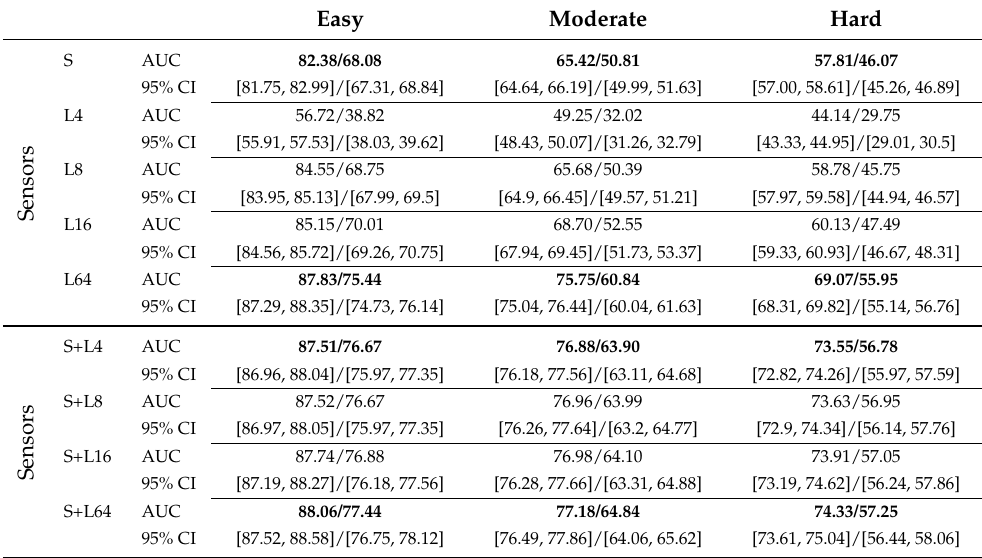
Table 5. Evaluation of 3D object detection performance by a stereo camera, different types of LiDARs, and the fusion of those. In the upper part of the table, the performance (measured using the area under the curve (AUC) in the P–R curve) and the confidence interval(s) (CI) of the stereo camera and LiDAR 4, 8, 16, and 64 beams are shown with respect to three levels of difficulties for objects to detect (easy, moderate, and hard). The bottom of the table presents the detection performance and CI using fusion between a stereo camera and LiDAR, i.e., 4-beam (S+L4), 8-beam (S+L8), 16-beam (S+L16), and 64-beam (S+L64). Each result is provided according to two indicators: average precision BEV (left)/average precision 3D (right).